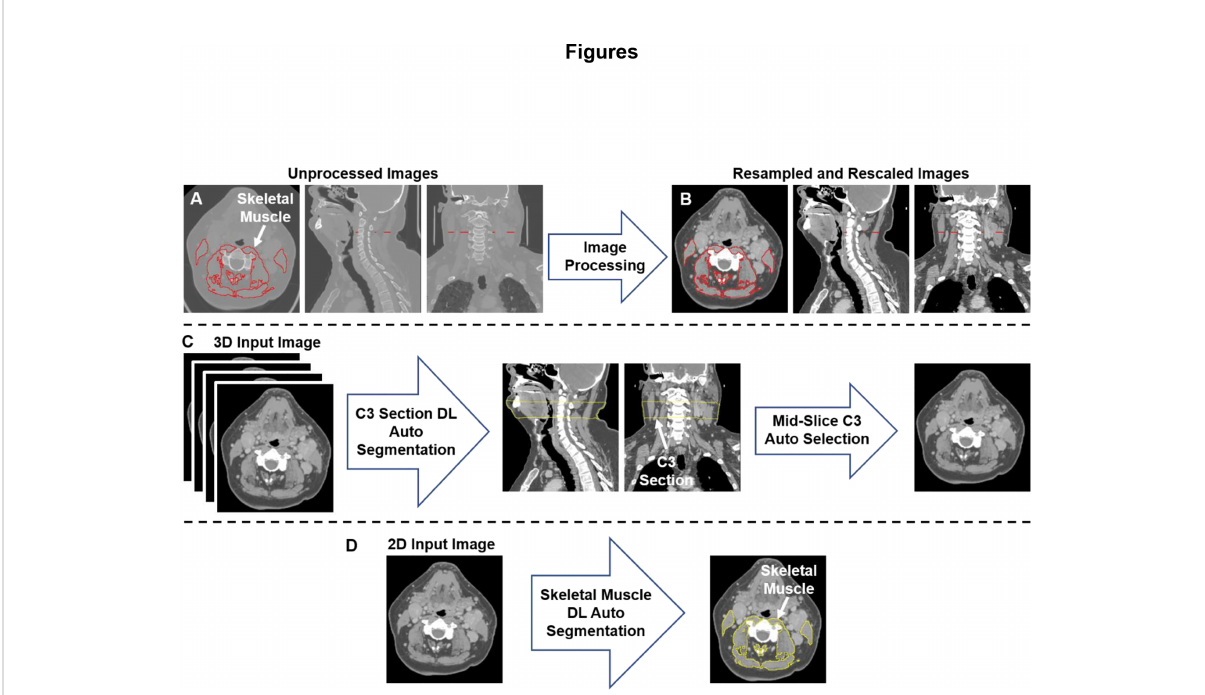
FIGURE 1 An illustration of the work fl ow used for skeletal muscle (SM) auto-segmentation at the C3 vertebra. (A) Overlays of the ground-truth SM segmentation and the original CT images. (B) Overlays of the ground-truth SM segmentation and the processed CT images. (C) An illustration of the work fl ow used to auto-select a single CT slice at the C3 vertebra for SM auto-segmentation. The auto-selected slice is the middle slice of the auto-segmented C3 section (33 mm in height) using a 3D ResUNet applied to the 3D volumetric CT image. (D) Auto-segmentation of SM using a selected C3 vertebra CT image using a 2D ResUNet